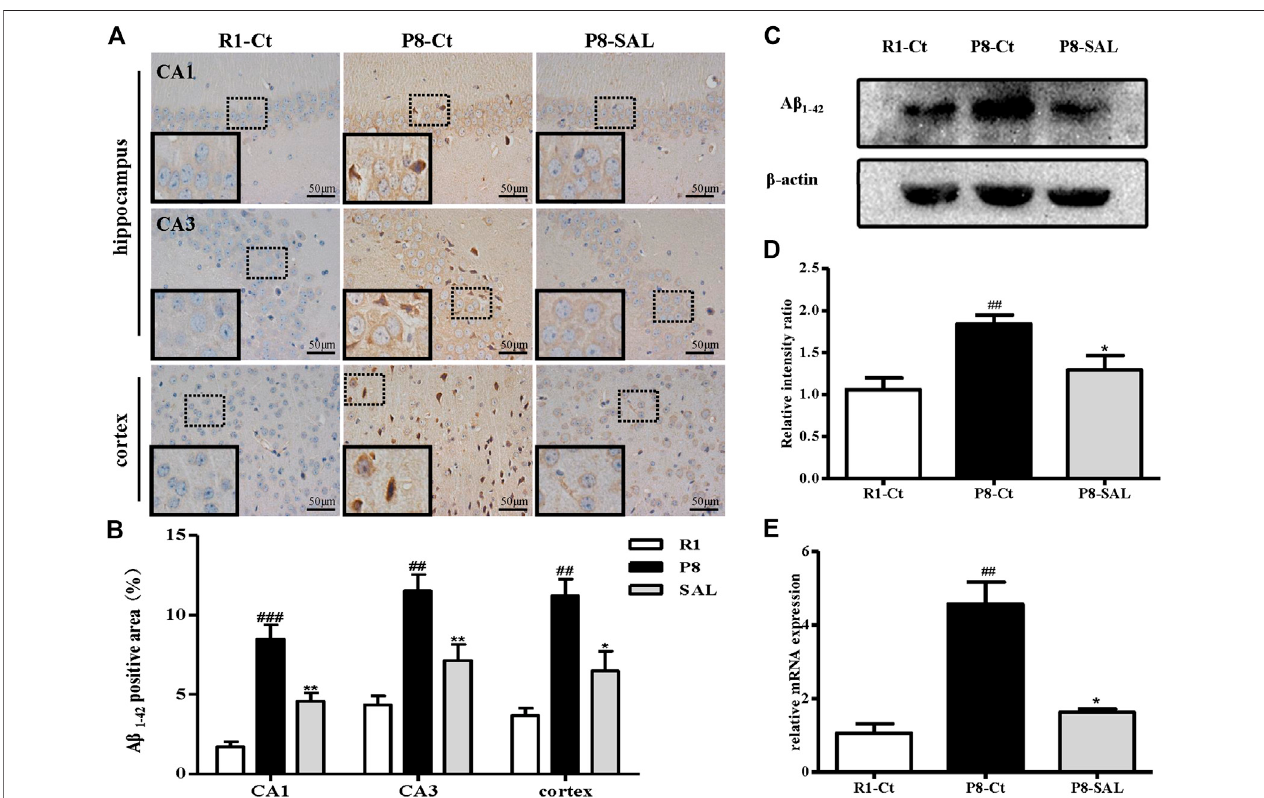
FIGURE3| EffectofSALonneurodegenerationinSAMP8mice. (A,B) Immunohistochemicalstainingand quanti fi cationofA β 1-42inthehippocampus andcortex in each group (magni fi cation × 400). The dotted box presents an enlarged image of the inset. (C) Western blot analysis of A β 1-42 expression and quanti fi cation in the hippocampus. (D) mRNA levels of APP determined by qPCR. All data are shown as the mean ± SEM ( n (cid:2) 3 for each group). ## p < 0.01, versus the R1-Ct group and * p < 0.05 versus the P8-Ct